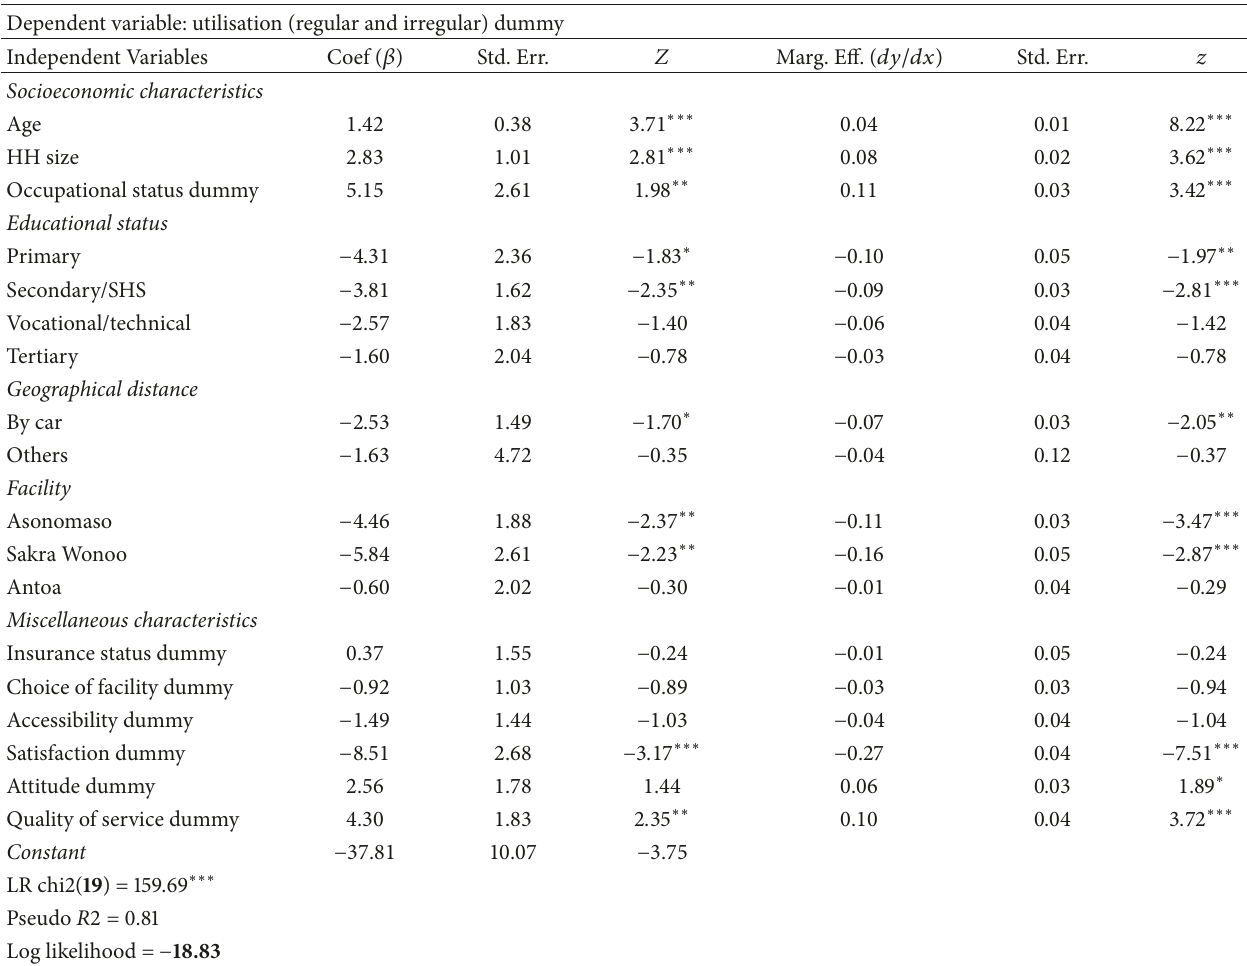
Table 3: Regression of ANC factors for the selected health